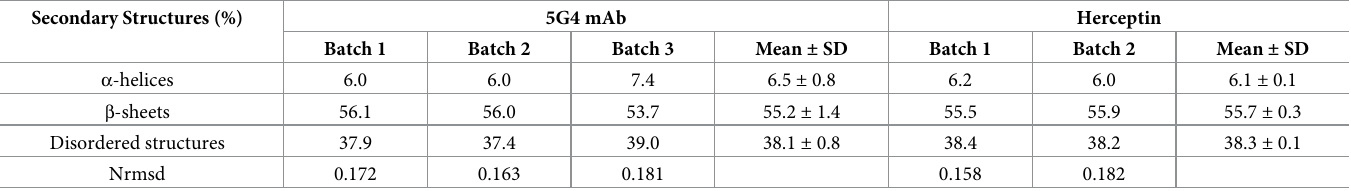
Nrmsd, Normalized root-mean-square deviation; SD, Standard deviation.